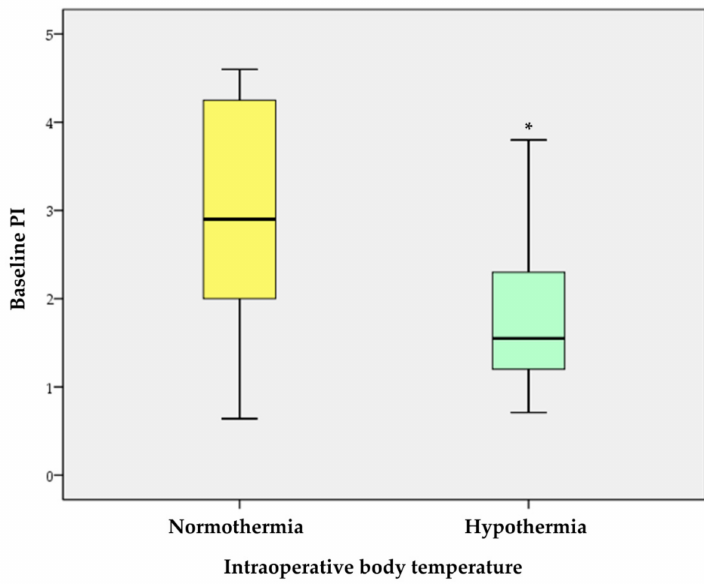
Figure 2. Baseline PI in normothermia and hypothermia groups. * indicates p <